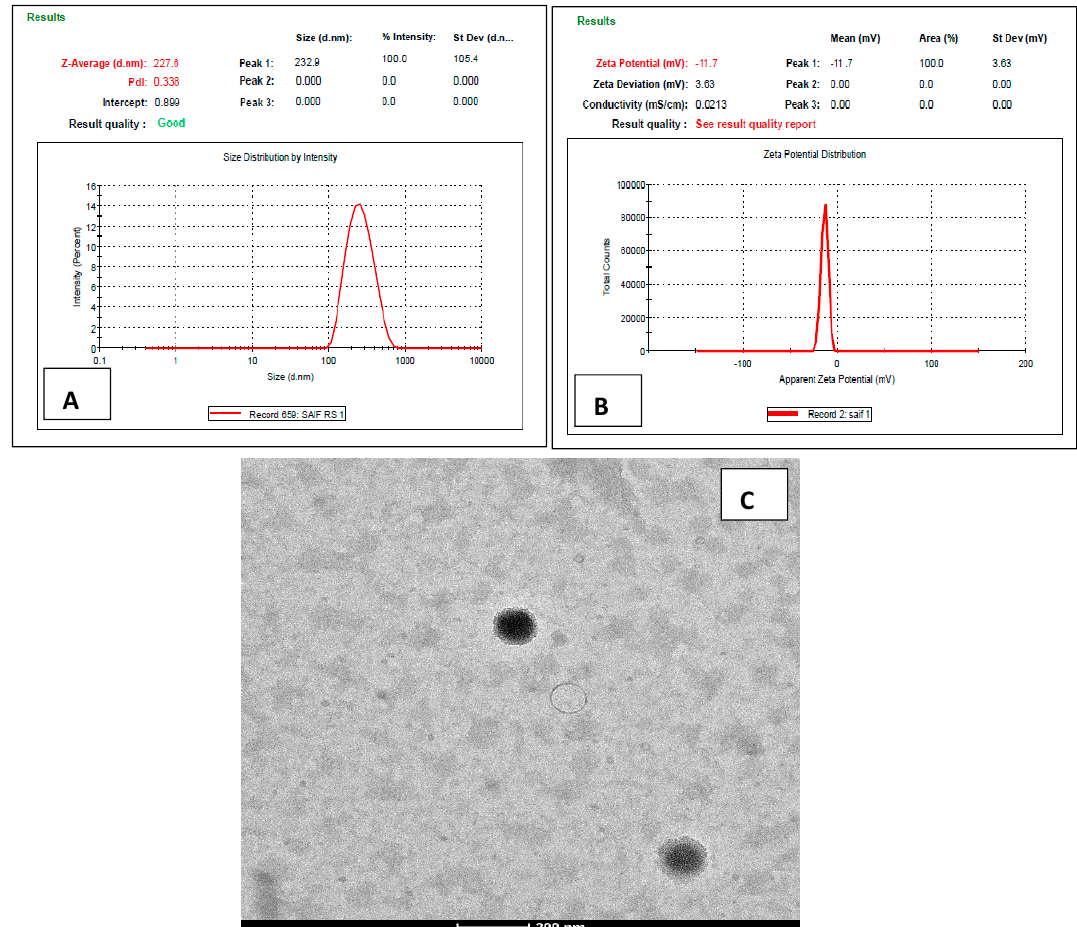
Figure 4. Image representing ( A ) particle size, ( B ) zeta potential, and ( C ) Transmission electron microscopy (TEM) image of optimized ATZ-NLC.